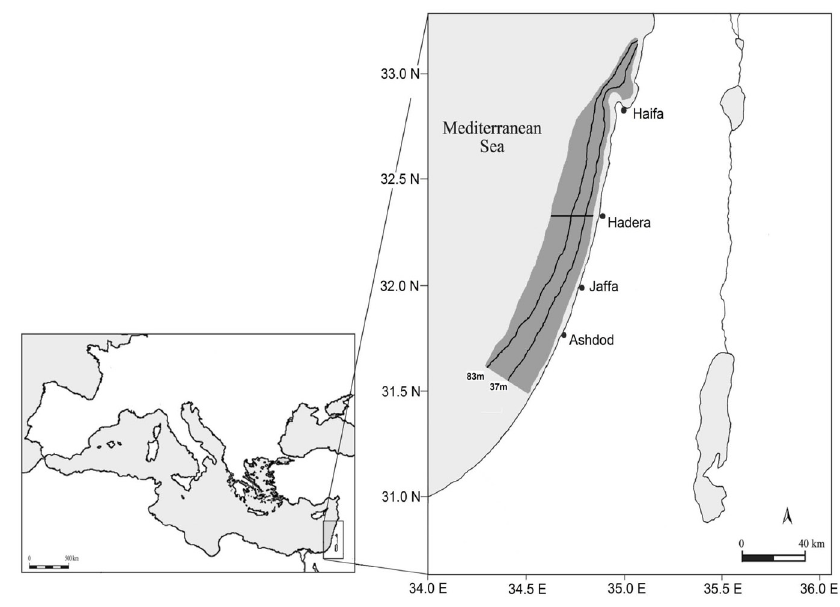
Fig . 1. – Map of the study site, with the main locations and isobaths mentioned in the text. The dark grey area represents the study area, cover- ing all the trawling grounds on the Israeli coast in the study period.